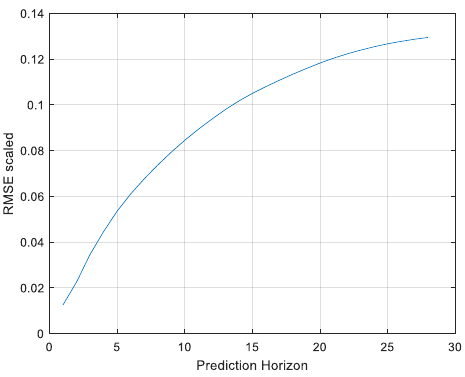
Figure 16. Evolution of RMSE over the prediction horizon — M 3.